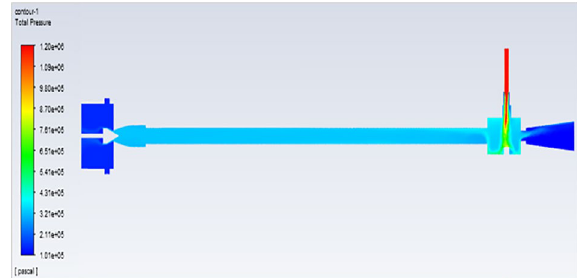
Figure 56. Pressure contours at 12 bar.